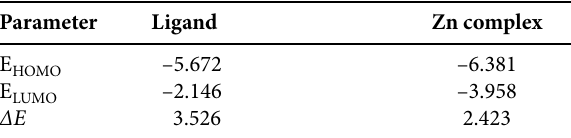
Table 3. HOMO-LUMO orbital energies (eV) and NBO Charges (e) of ligand (L) and its complex Parameter